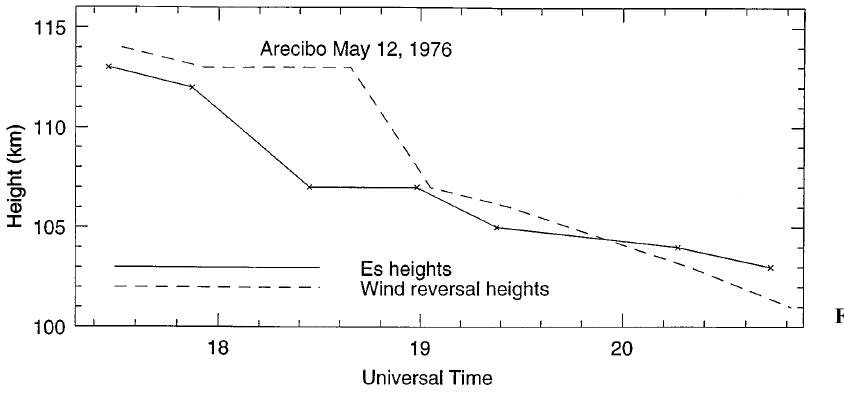
Fig. 3. As for Fig. 2 but for May